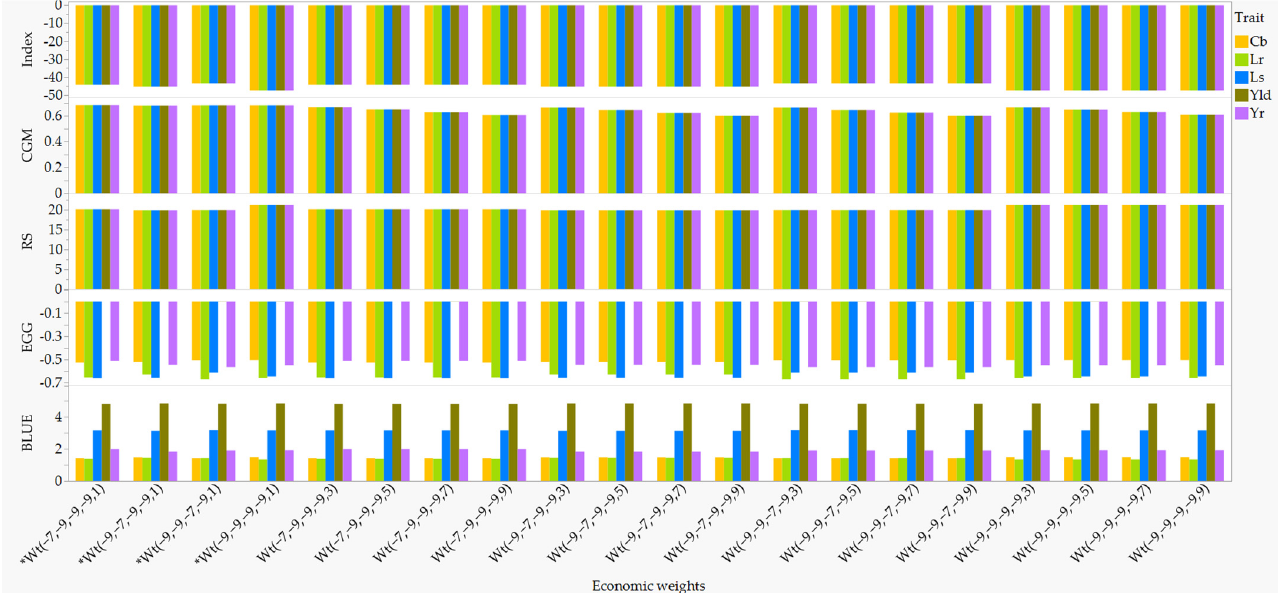
Figure 3. Bar graphs of best unbiased estimators (BLUEs) computed from all environments and the four selection parameters: the expected genetic gain (EGG) per trait, response to selection (RS), index, and the correlations between the index and genetic merit (CGM). The plots were made only for the top 20 of 3215 economic weights of which the four selected economic weights have * as a prefix. Trait acronyms—Cb (common bunt), Lr (leaf rust), Ls (leaf spot), Yld (grain yield), and Yr (stripe rust). See Table S5 for details.